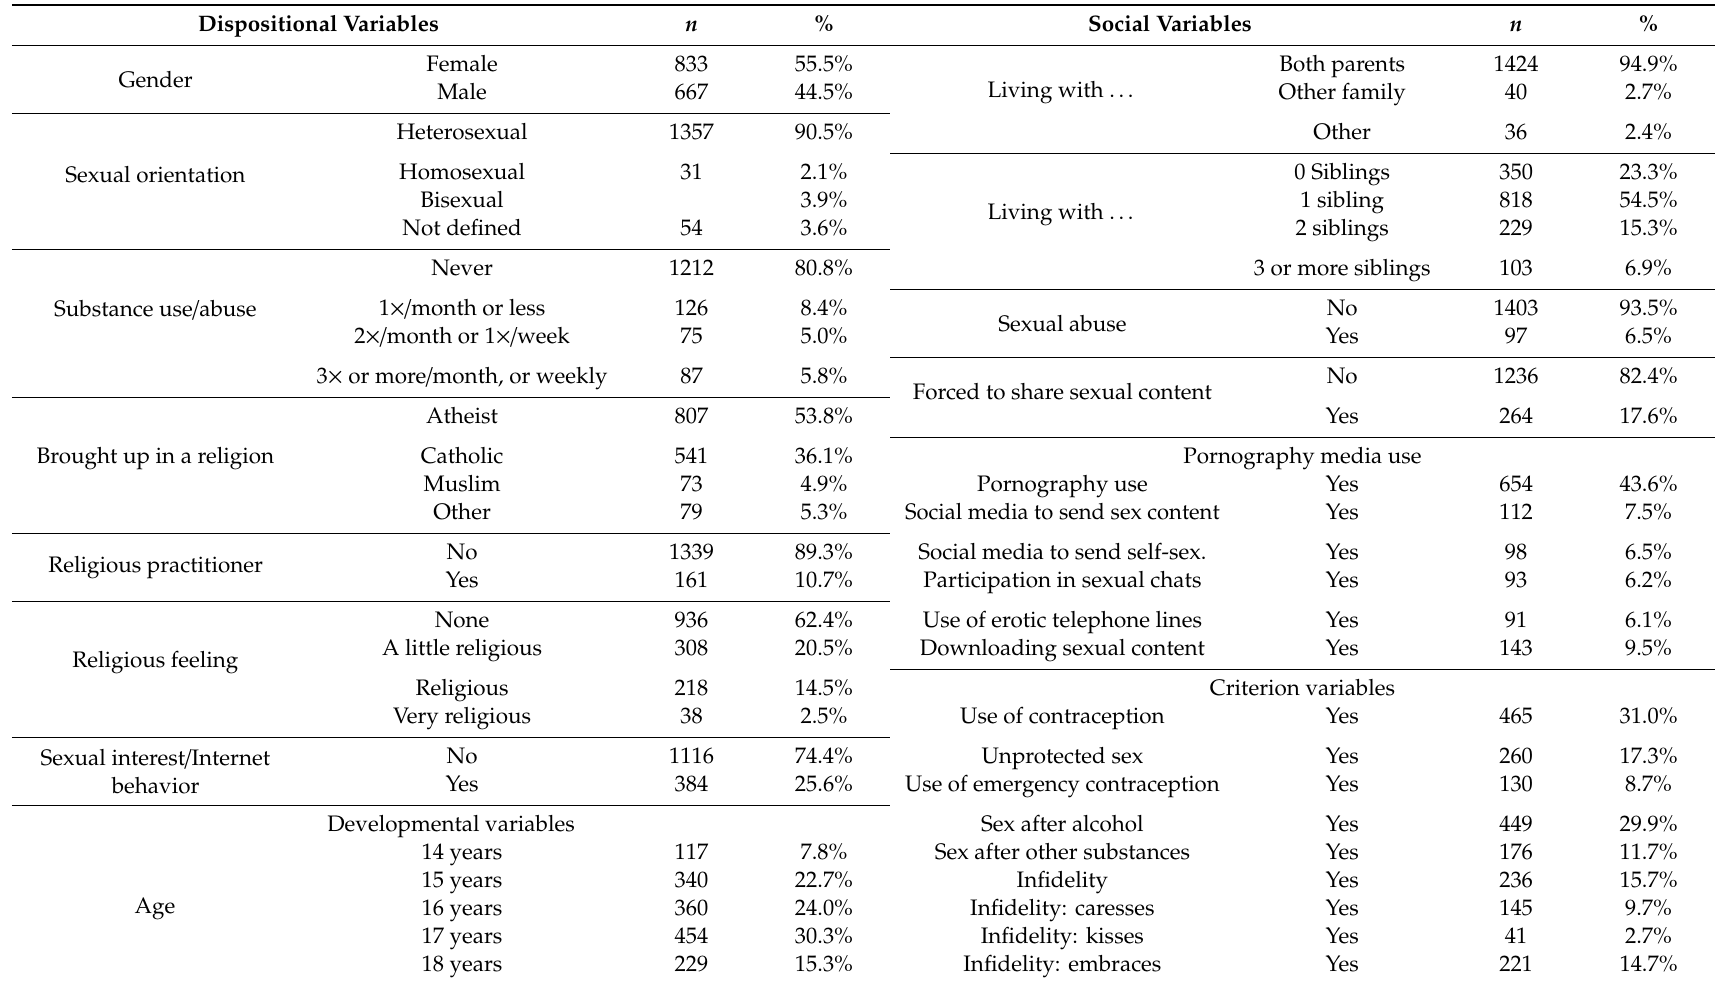
Table 1. Descriptive variables of the study ( n =